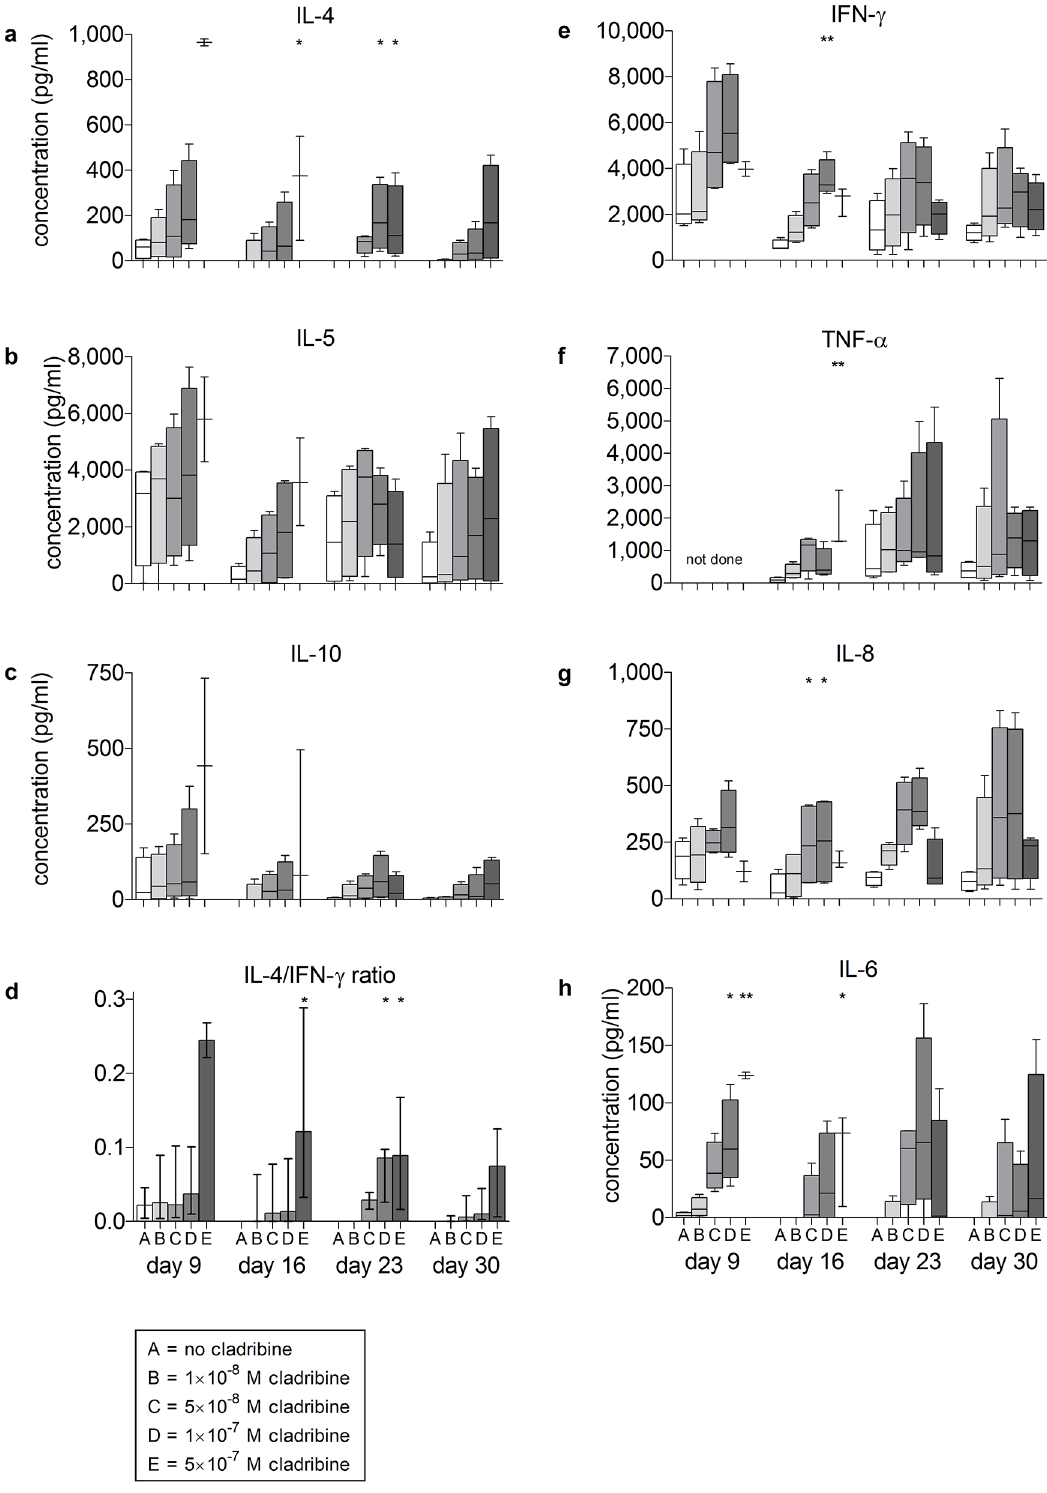
Fig 5. In vitro effects of initial cladribine treatment on cytokine secretion of PBMCs restimulated at Days 9, 16, 23 and 30 after transfer into cladribine-free medium. PBMCs from healthy blood donors (n = 4) were incubated in the absence or presence of cladribine . (1×10 − 8 M to 5×10 − 7 M) for 72 h. Then cells were washed three times and transferred into cladribine-free medium. Cells were restimulated with PHA for 48 h at days 9, 16, 23 and 30;